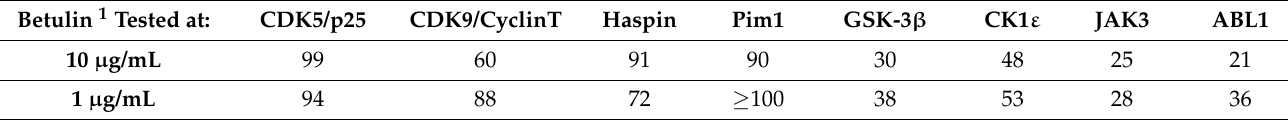
1. Data in the Table represent the % of kinase activity that remained following treatment of each kinase with 10 or 1 µg/mL of betu- lin, normalized to control (that is, kinase activity in the presence of the vehicle, DMSO, only). ATP concentration used in the kinase assays was 10 µM, and values given represent mean (n = 2). A value ≥ 100 indicates that the compound does not detectably inhibit the enzymatic activity at the tested concentration.